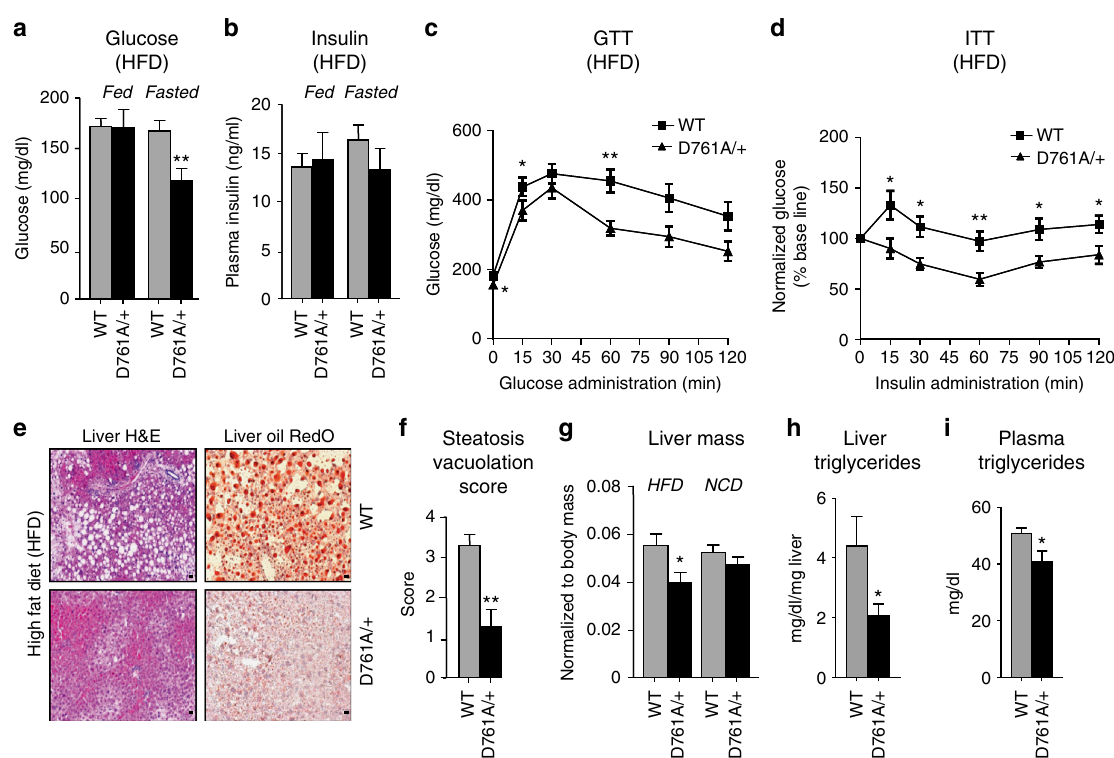
Fig. 3 Impact of Vps34 inactivation on glucose tolerance, insulin sensitivity in HFD-fed mice. a Serum glucose levels in randomly fed and fasted mice. Data represent mean ± SEM (non-parametric Mann – Whitney t -test). b Serum insulin levels in randomly fed and fasted mice. Data represent mean ± SEM (non- parametric Mann – Whitney t -test). c GTT after intraperitoneal injection of 2 g/kg of glucose in mice in overnight- starved mice. Data represent mean ± SEM (non-parametric Mann – Whitney t -test). d ITT after intraperitoneal injection of 0.75 U/kg of insulin in overnight-starved mice. Data represent mean ± SEM (non-parametric Mann – Whitney t -test). e Hematoxylin and eosin (H&E) staining and Oil Red O staining of liver sections of mice after 16 weeks of HFD. Representative image derived from 6 livers/genotype of mice. Scale bar, 10 µ m. f Quanti fi cation of vacuolation of 6 livers/genotype of mice after 16 weeks of HFD. a.u., arbitrary units. Data represent mean ± SEM (non-parametric Mann – Whitney t -test). g Comparison of liver weight of mice fed a NCD or HFD. Data represent mean ± SEM (non-parametric Mann – Whitney t -test). Quanti fi cation of 5 – 9 livers/genotype. h Triglyceride levels in liver of mice challenged with 45% HFD for 16 weeks. Data represent mean ± SEM (non-parametric Mann – Whitney t -test). i Plasma triglyceride levels of mice challenged with 45% HFD for 16 weeks. Data represent mean ± SEM (non-parametric Mann – Whitney t -test). For all experiments shown, ≥ 10 mice/ genotype were used. * p < 0.05, ** p ≤ 0.01, *** p ≤